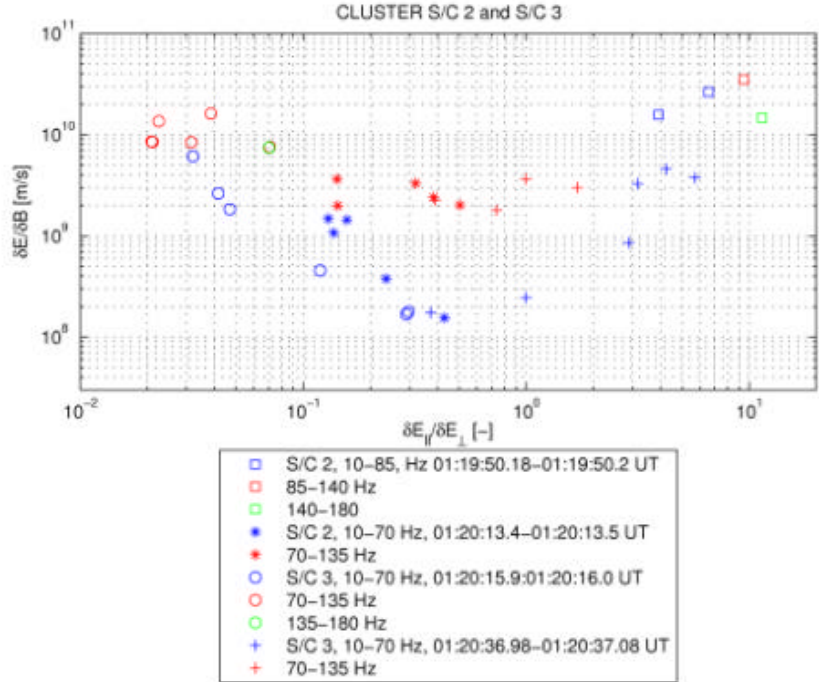
Fig. 7. Detailed analysis of the time intervals indicated in yellow in Figs. 3–6, see the text for details. Different symbols correspond to different intervals, while different colours correspond to different frequency